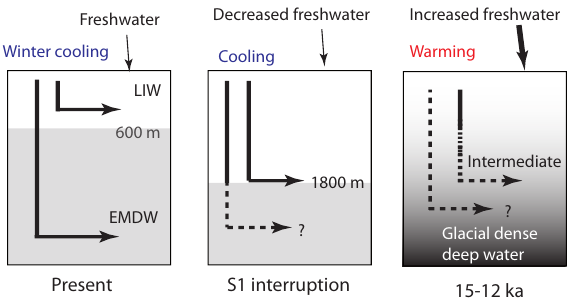
Figure 6. Schematic ventilation patterns in the eastern Mediter- ranean Sea at present, S1 interruption and